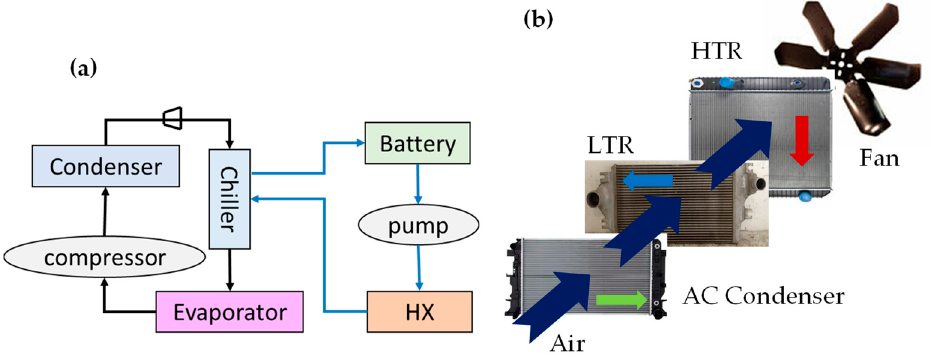
Figure 3. Thermal management systems for battery and FCS. The drivetrains have separate circuits for cooling the traction motor and the final drive. ( a ) Battery thermal management system (BTMS); ( b ) FCS heat rejection